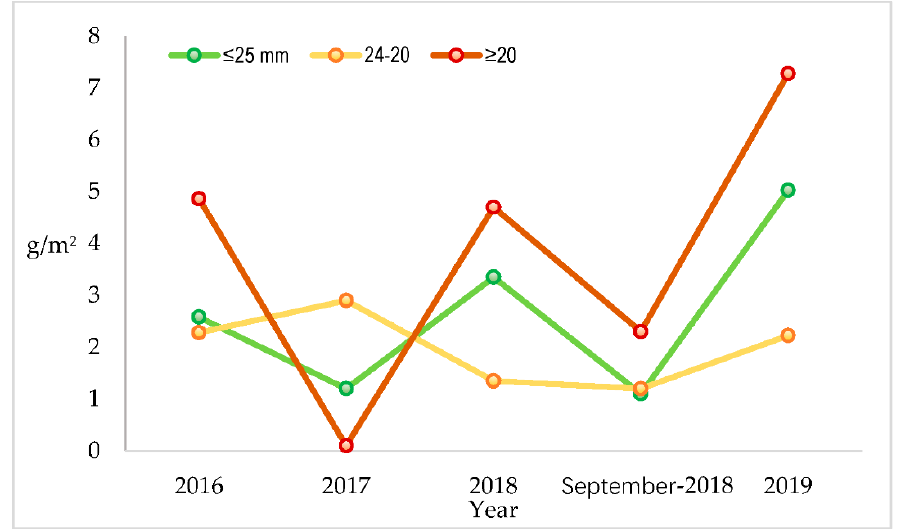
Figure 4. Trend of Chamelea gallina (divided by size as shell total length; mm) for the Lignano Sabbiadoro area in the years 2016 – 2019 [73,116].